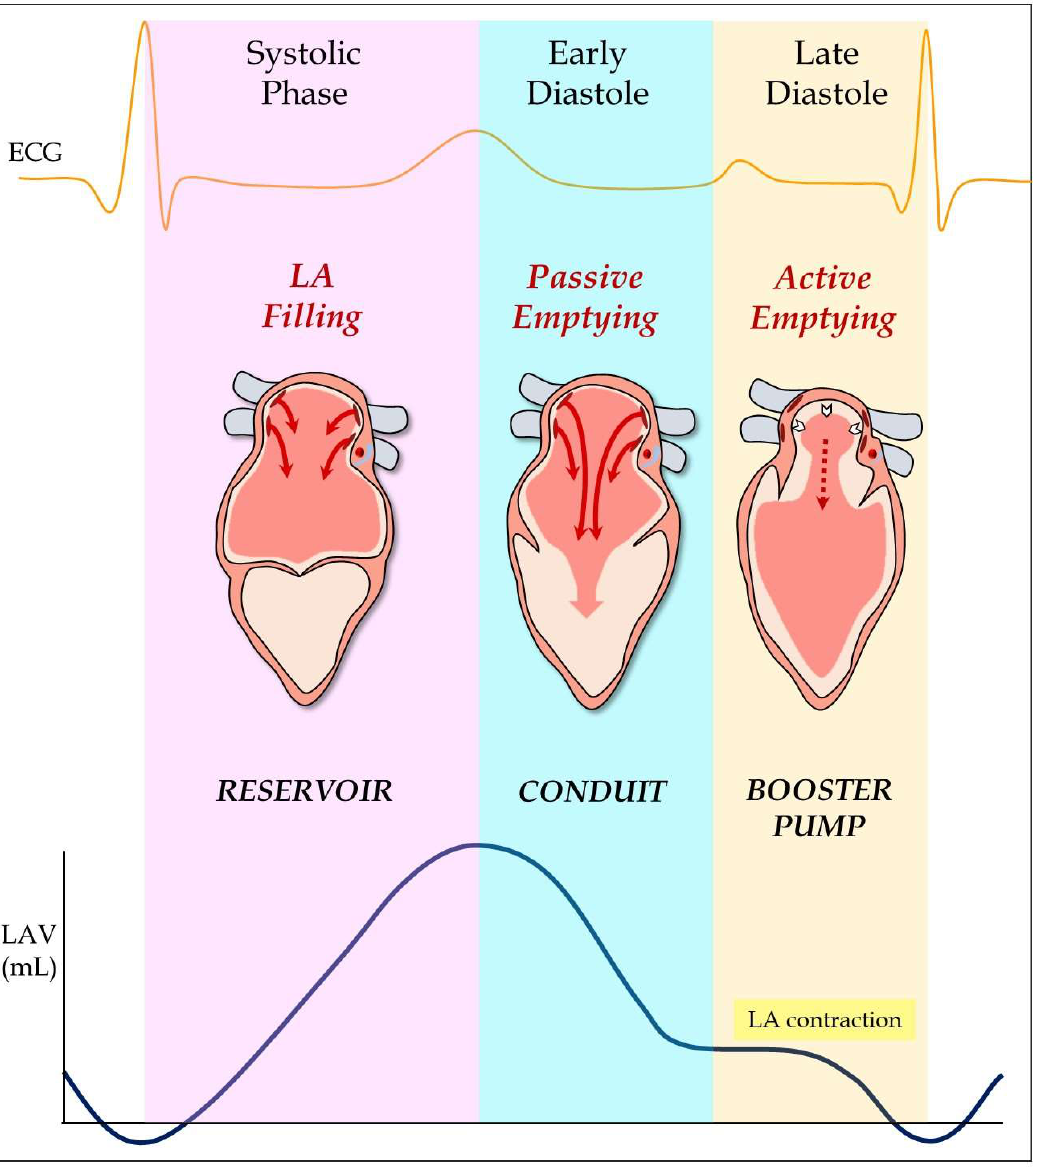
Figure 2. Mechanical function of the LA showing the three different phases during the cardiac cycle: left atrial filling, passive emptying and active emptying.